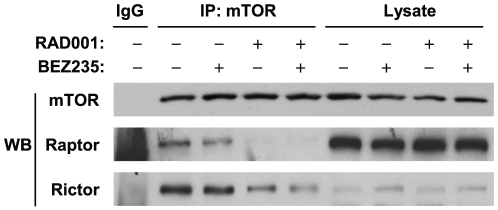
The combination of RAD001 and BEZ235 does not enhance disruption of mTORC assembly.A549 cells were treated with 2 nM RAD001, 10 nM BEZ235 or their combination. After 24 h, the cells were harvested for preparation of whole-cell protein lysates and subsequent IP-Western blotting.